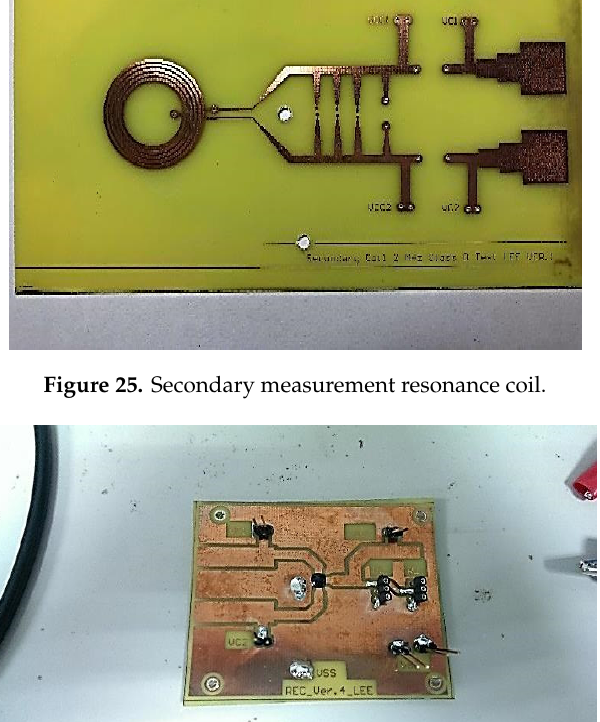
Figure 26. Bootstrapped Rectifier IC and its PCB. Table 2. PCB Coil Parameter Data.